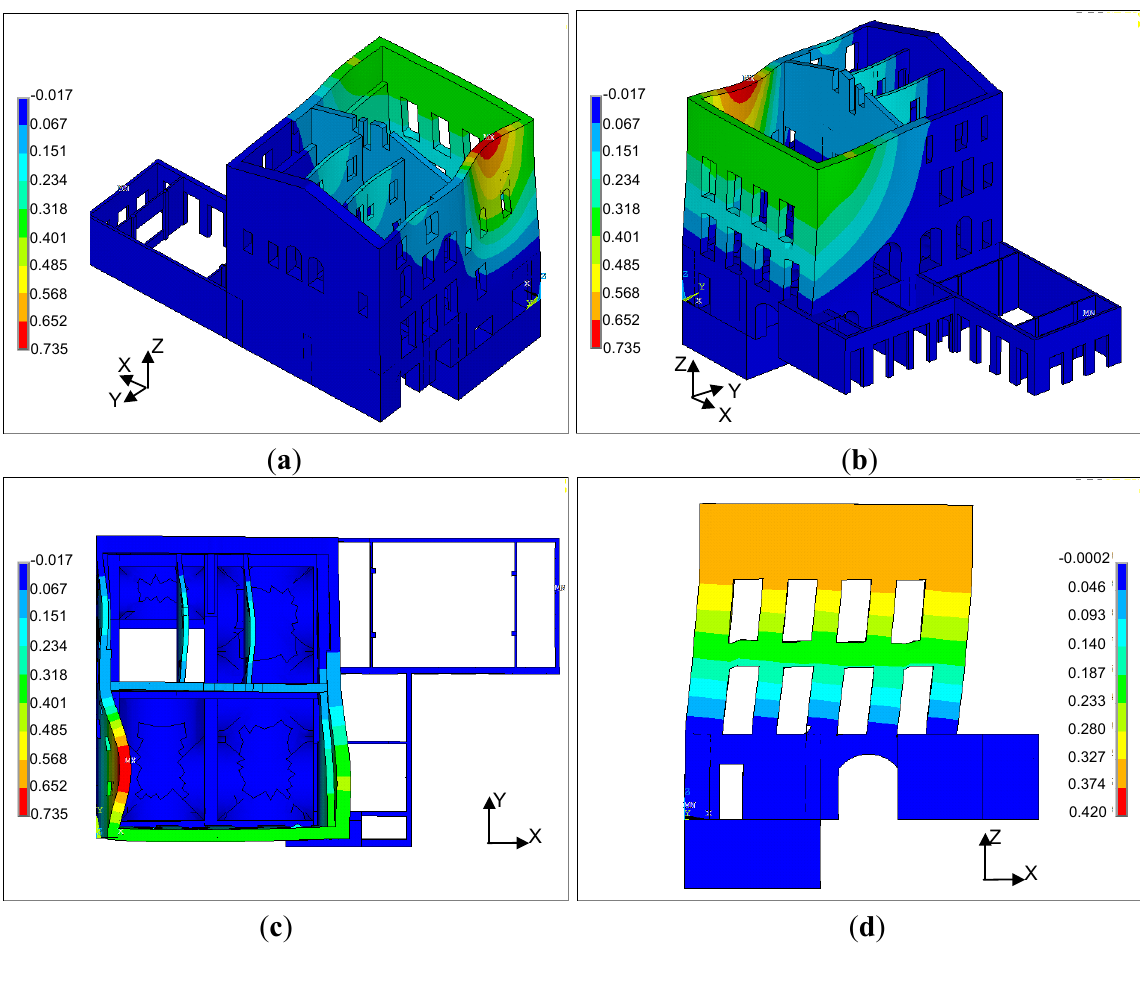
Figure 11. Pushover analysis results (+X direction): ( a ), ( b ), ( c ) and ( d ) horizontal displacement in X direction (units are